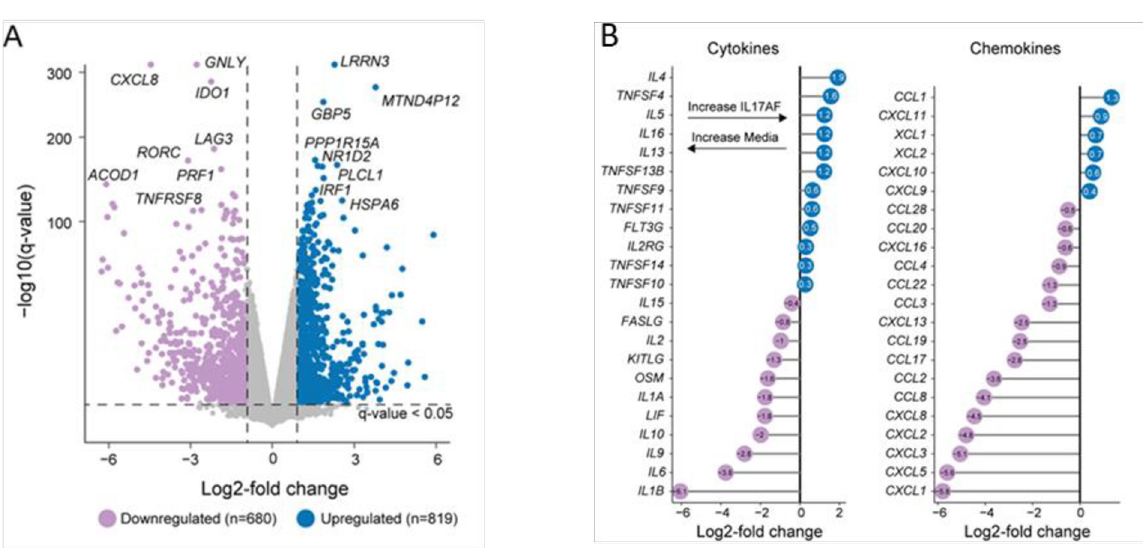
Fig 6. Detailed analysis of significant IL-17AF mediated changes in cytokines and chemokines. Volcano plot of differential genes identified comparing IL-17AF to media-only cells. Highlighted cells have q-value < 0.05 and log2-fold change > 1 or < -1. Selected genes labeled were in the top 20 genes by q-value. B . Filtered cytokine and chemokine genes with q-value < 0.05.